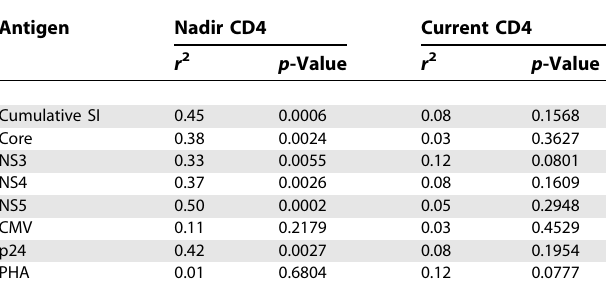
Table 2. LP Responses to HCV Antigens in HIV þ HCV Controllers Correlate More Strongly with Historical Nadir CD4 þ T Cell Counts Than with Contemporaneous CD4 þ T Cell Counts